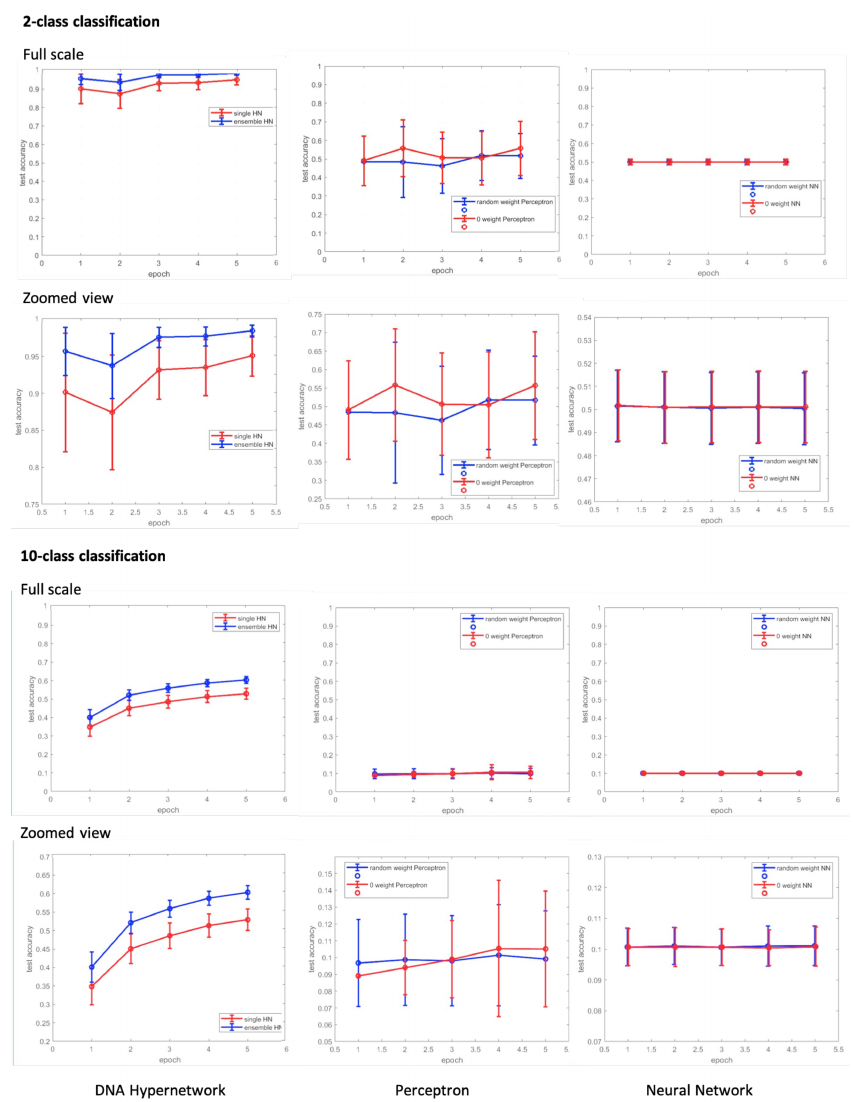
Figure 8. In silico experimental results. Computer simulation of 2-class classification with hypernetwork d. Computer simulation of 10-class classification with